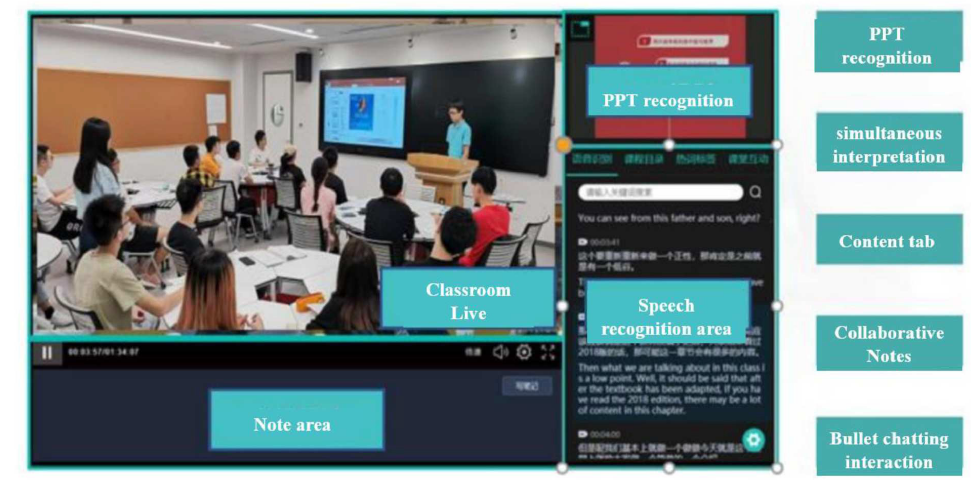
Fig. 3 The visual teaching scene of Zhiyun